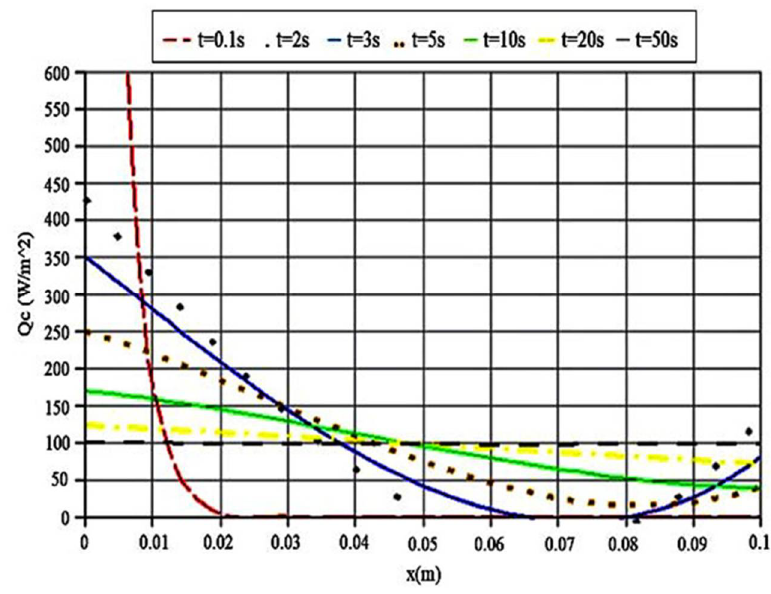
Figure 5. Conductive heat flux in various time steps.